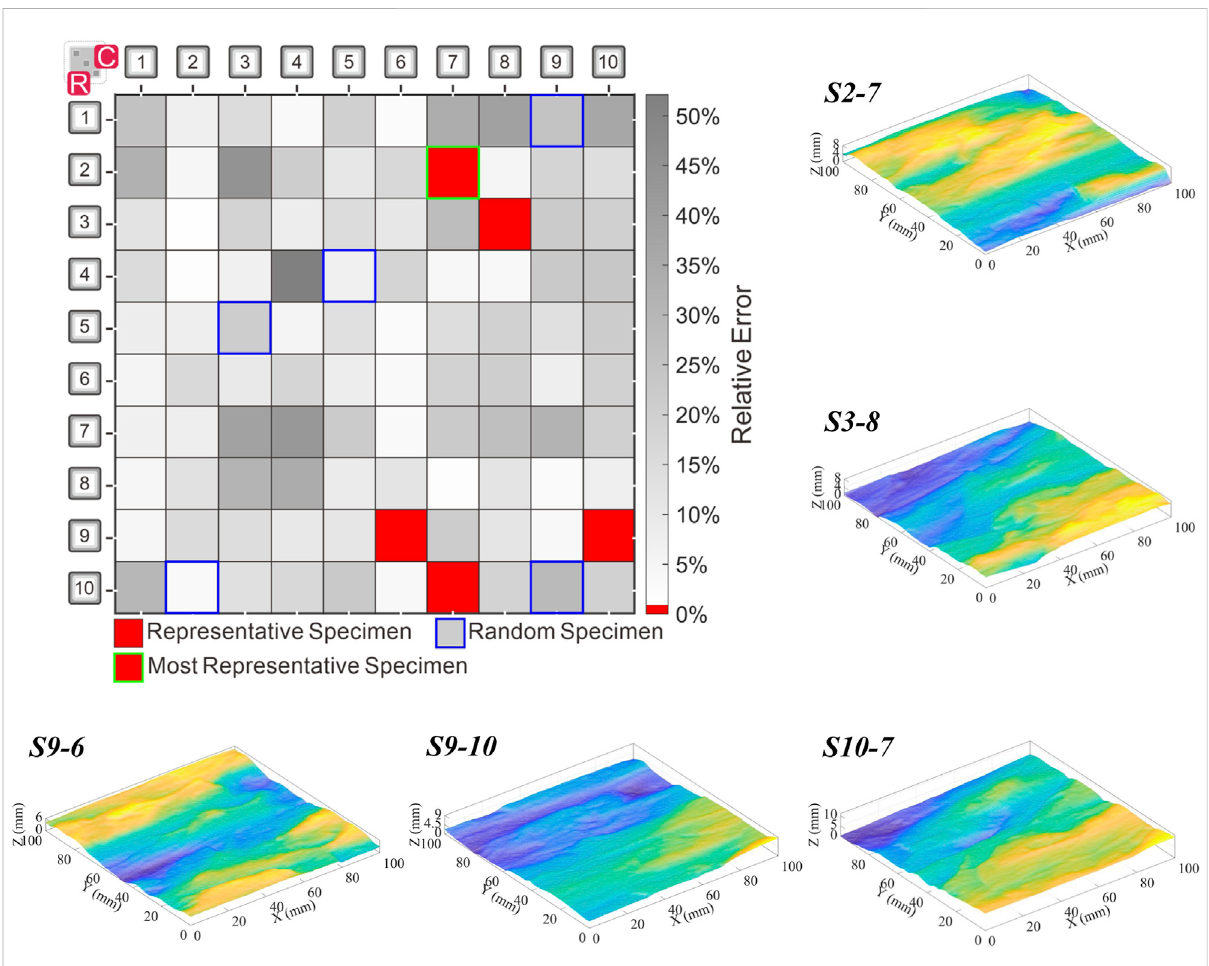
FIGURE 12 Locations and morphology of the top fi ve representative specimens (note: the shear direction is along the negative direction of the Y -axis).